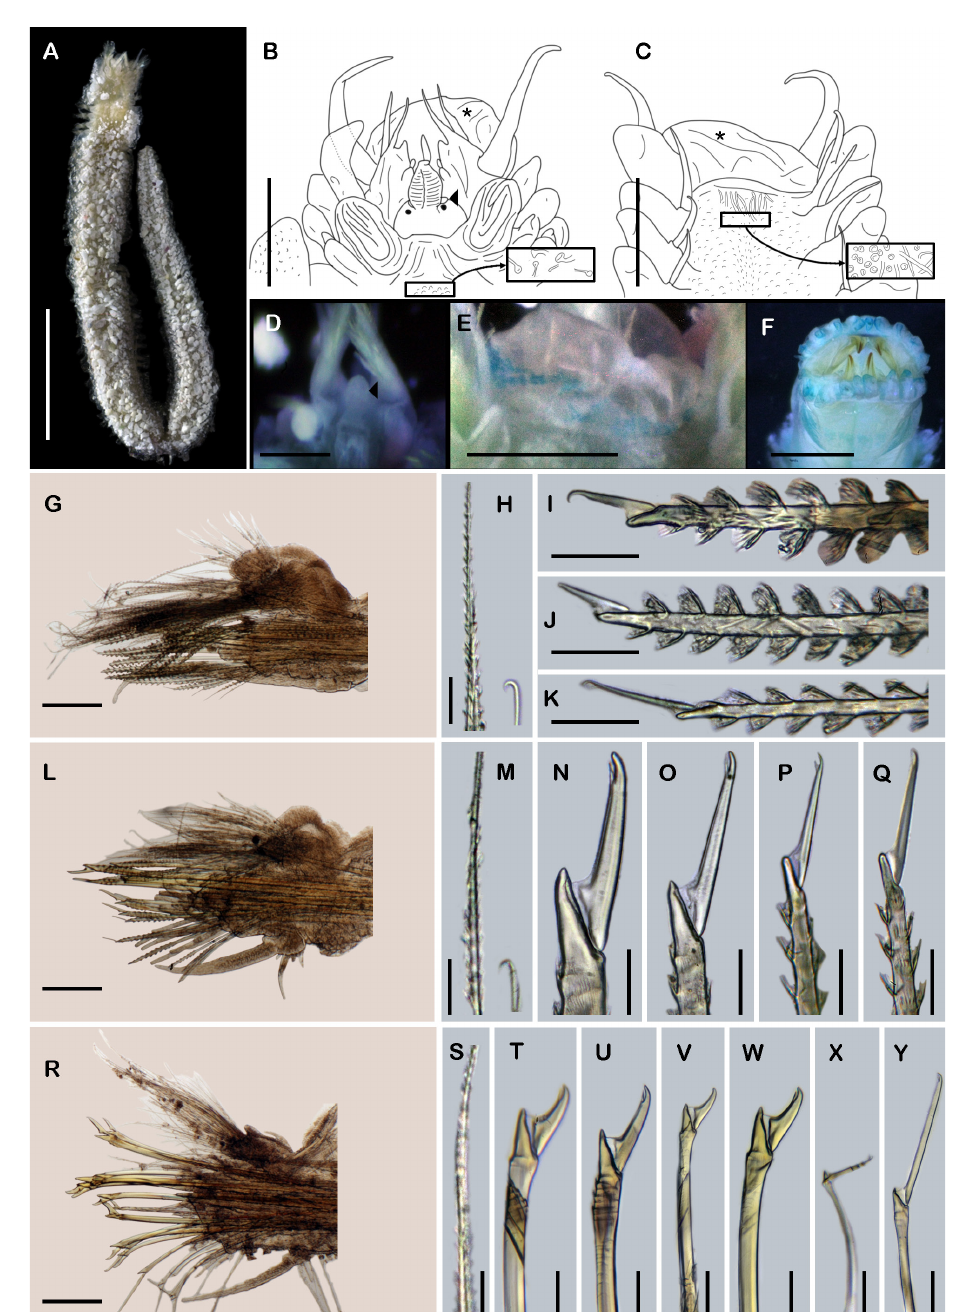
Fig. 3. Dayipsammolyce paulayi sp. nov. A–D, G–Y . Holotype (UF 2777). E–F . Paratype (UF2618). A . Complete worm, dorsal view. B . Anterior end, dorsal view, arrowhead indicates ctenidia (insert: dorsal papillae); asterisk indicates partially everted pharynx. C . Anterior end, ventral view (insert: ventral papillae); asterisk indicates partially everted pharynx. D . Close-up of C, arrowhead indicates facial tubercle. E . Marginal pharyngeal papillae. F . Detail of pharynx. G . Right parapodium from segment II. H . Notochaeta from same. I . Unit A. J . Unit B. K . Units C and D. L . Right parapodium from segment III. M Notochaeta from same. N . Unit A. O . Unit B. P . Unit C. Q . Unit D. R . Right parapodium from segment 32. S . Notochaeta from same. T . Unit A. U . Unit B. V . Unit C. W . Subunit 1. X . Subunit 2. Y . Unit D. Scale bars: A = 5 mm; B–C = 1 mm; D–F = 500 μm; G, L, R = 200 μm; H–K, M–Q, S–Y = 40